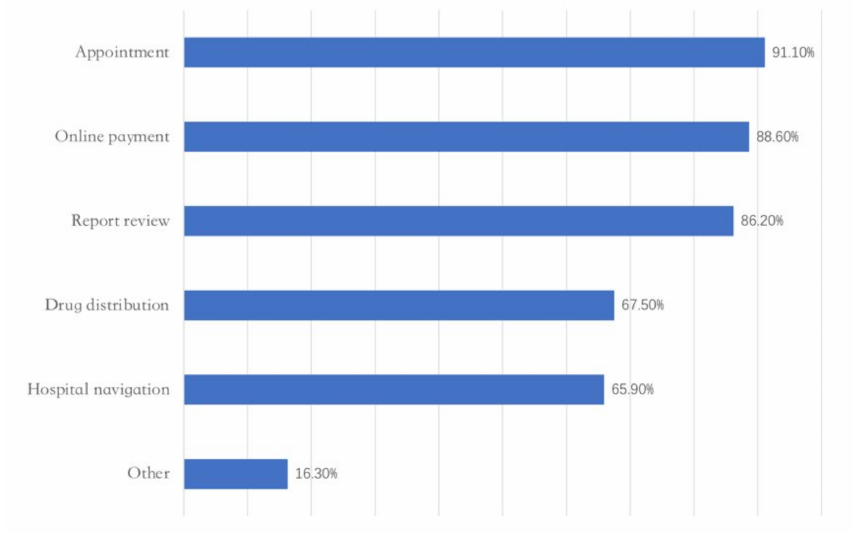
Figure 5. Regular services in hospitals. Adapted from source: National Telemedicine Center of China [23]).